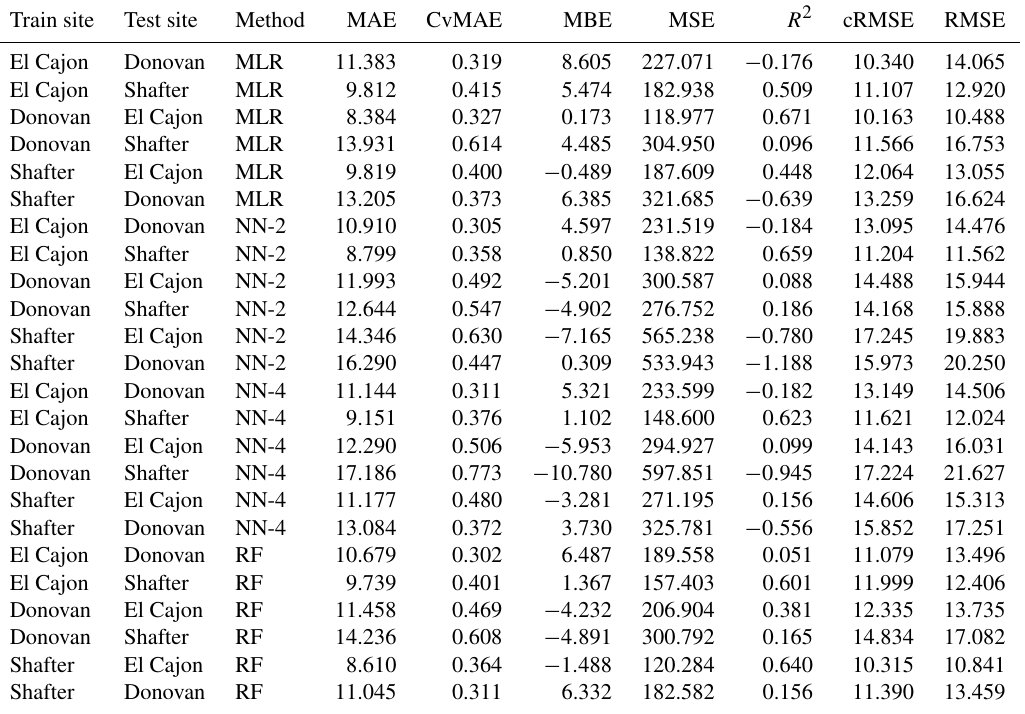
Table C8. Level 1 test results for O 3 .